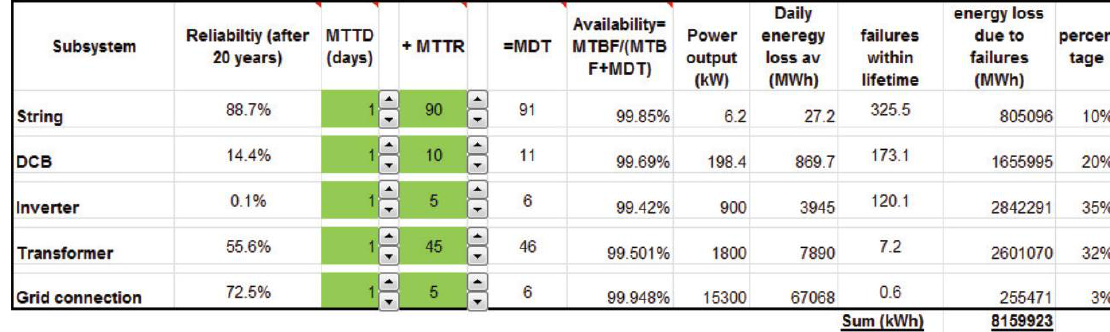
Figure 9 . Occurrences of failures per subsystem ( a ) share of total losses divided ( b ) per subsystem for the string inverter scenario. There are obviously some uncertainties in the given failure rates, but the methodology given above should be a tool to evaluate the value of component reliability in LSPVS. Some items in Table 1 exhibit a broad range of reported failure rates. For instance, the MTBF for PV modules range between 218 and 16,386 years. This change would have a dramatic effect reducing the EA from around 98.4% to 95.5% at a standard repair time of 90 days (=average time between half year inspection). The magnitude of failure rates for string fuses also varies significantly between 0.02 × 10 −6 /h and 5.71 × 10 −6 /h. This change would have a relatively small impact on E A (98.38% down to 97.14% at a higher failure rate).